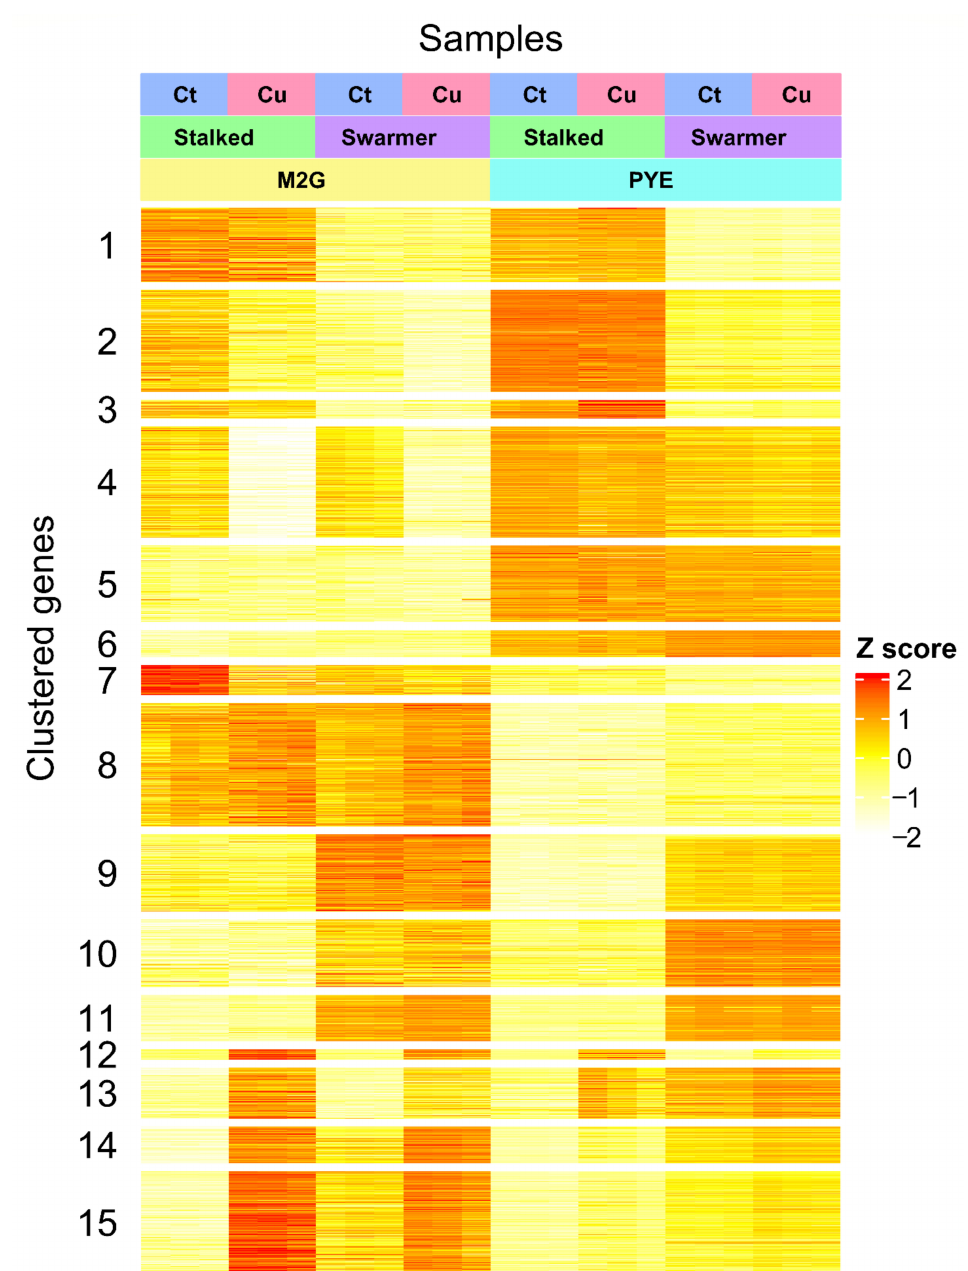
Figure 4. Read coverage heatmap of the 2000 most variable genes in 15 clusters. Z scores were calculated by subtracting row-average value from corresponding cell value and dividing by row standard deviation. Fifteen gene clusters were created by K-means clustering. Experimental conditions: Cu stress (blue), no Cu stress (red); cell type: stalked cells (green), swarmer cells (purple); medium: M2G medium (yellow), PYE medium